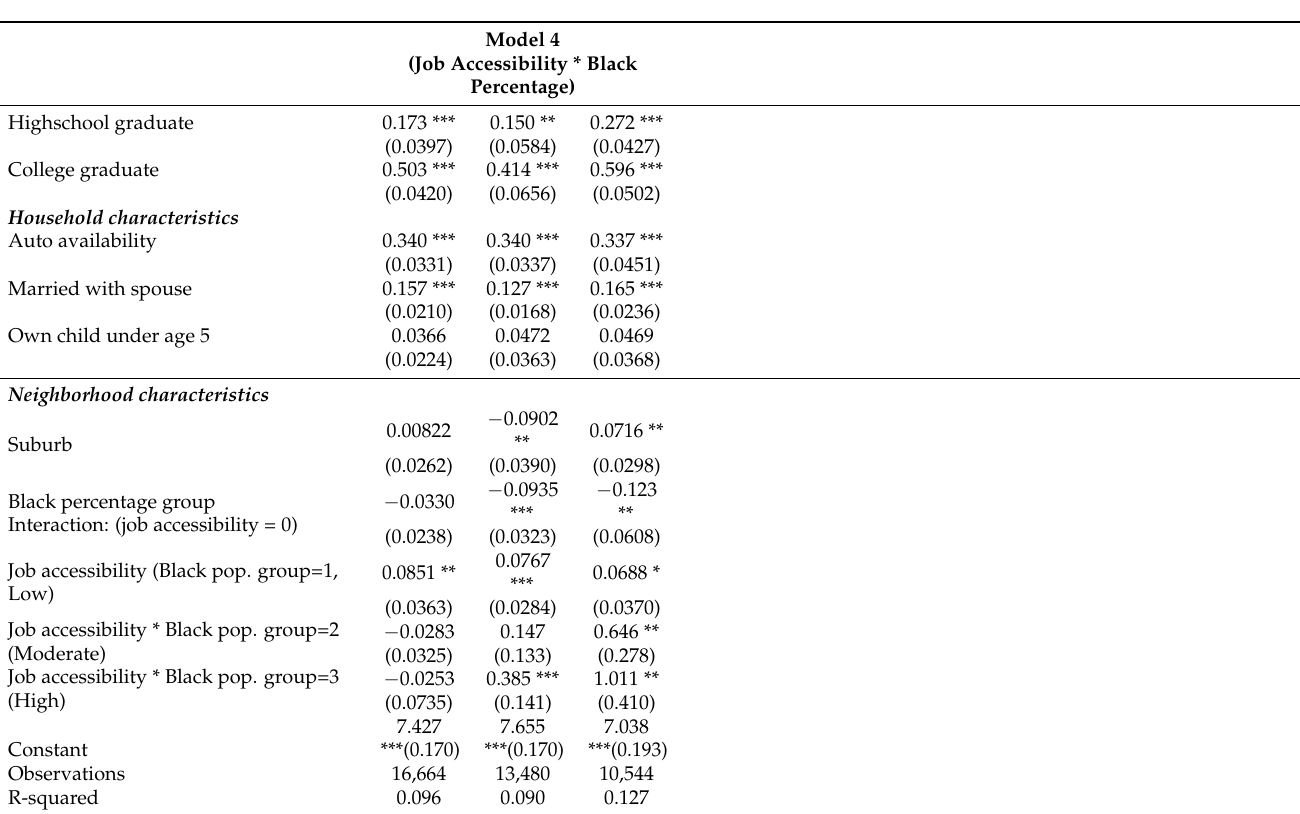
Table 3. Cont. Model 4 (Job Accessibility *